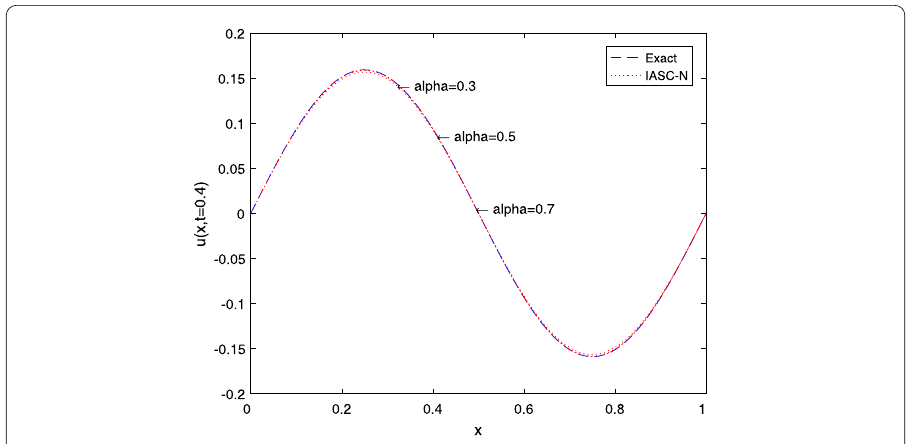
Figure 6 Comparison of the IASC–N scheme solution and the analytical solution